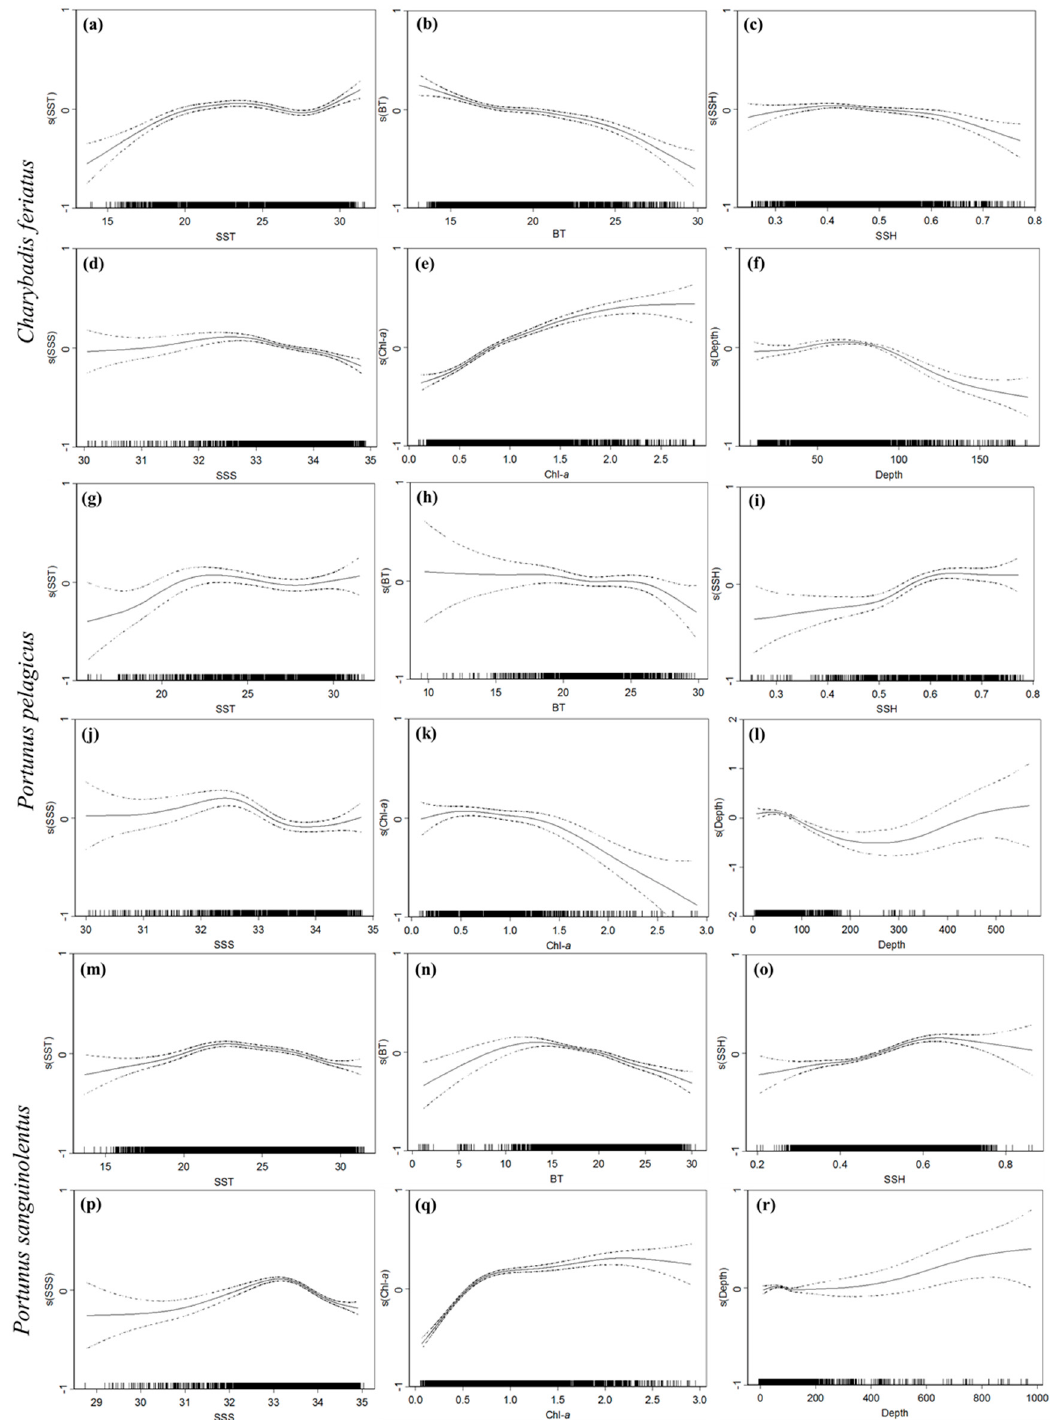
Figure 5. Effects of environmental factors on catch rates of three commercial swimming crabs in the TS: ( a )–( f ) C. feriatus , ( g )–( l ) P. pelagicus , and ( m )–( r ) P. sanguinolentus . The black dotted and solid lines in